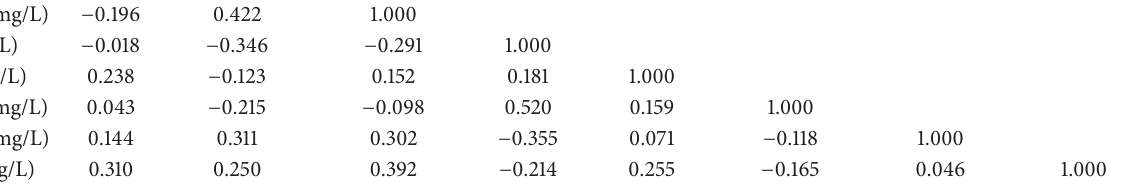
Lahore 𝑟 values are significant at 0.229 at 𝑃 > 0.05 . Sialkot 𝑟 values are significant at 0.265 at 𝑃 > 0.05 . Table 3: Varimax normalized factor loading for various parameters of drinking water samples from Lahore and Sialkot.